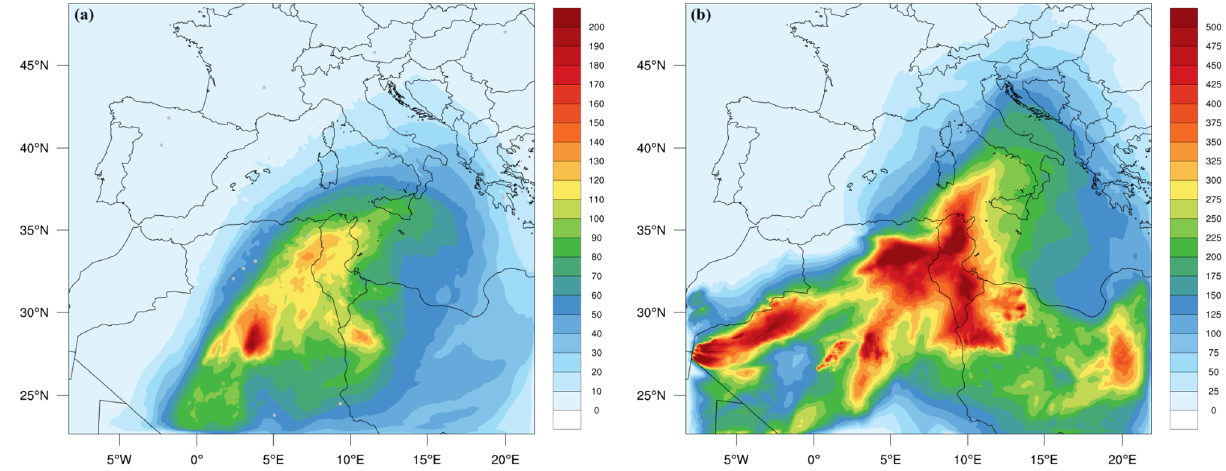
Figure A4. Averaged (17–24 June) total dust at 500 hPa ( a ); 900 hPa ( b ). Units are μg m − 3 .